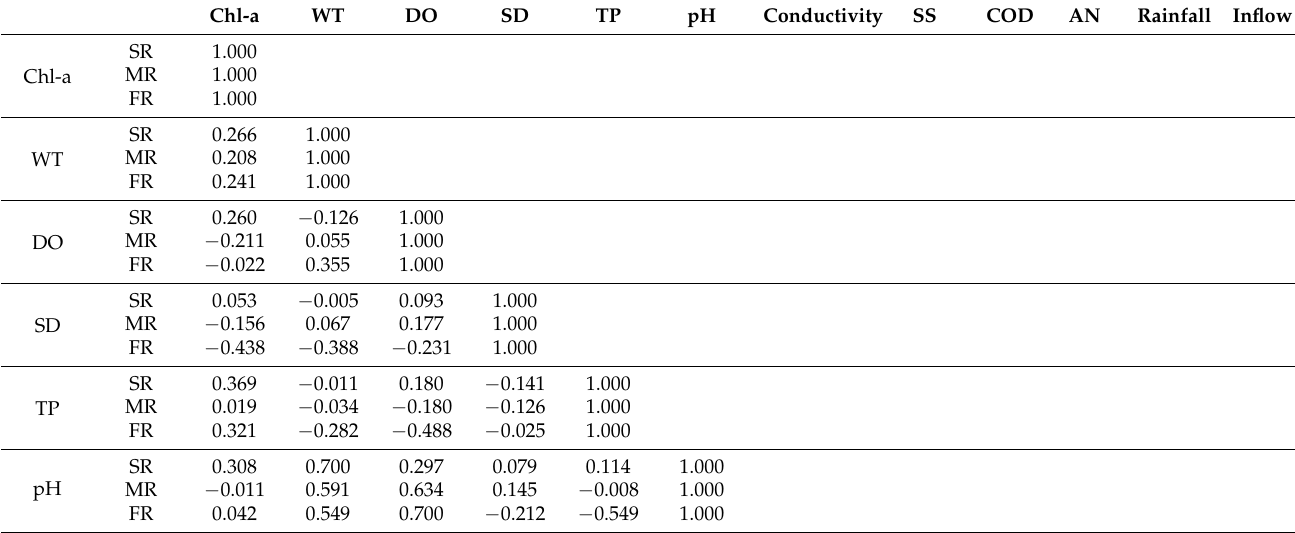
Table 3. Correlation coefficients between factors from correlation analyses (1/2).